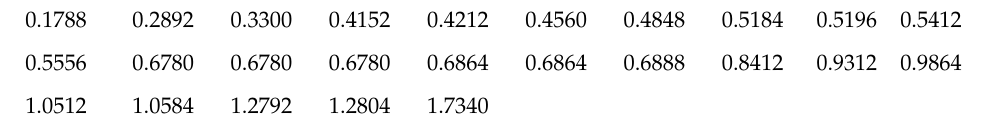
Figure 9. Minimum total cost curve for p = 0.05, 0.075, 0.1 at α = 0.1 and β = 0.25.